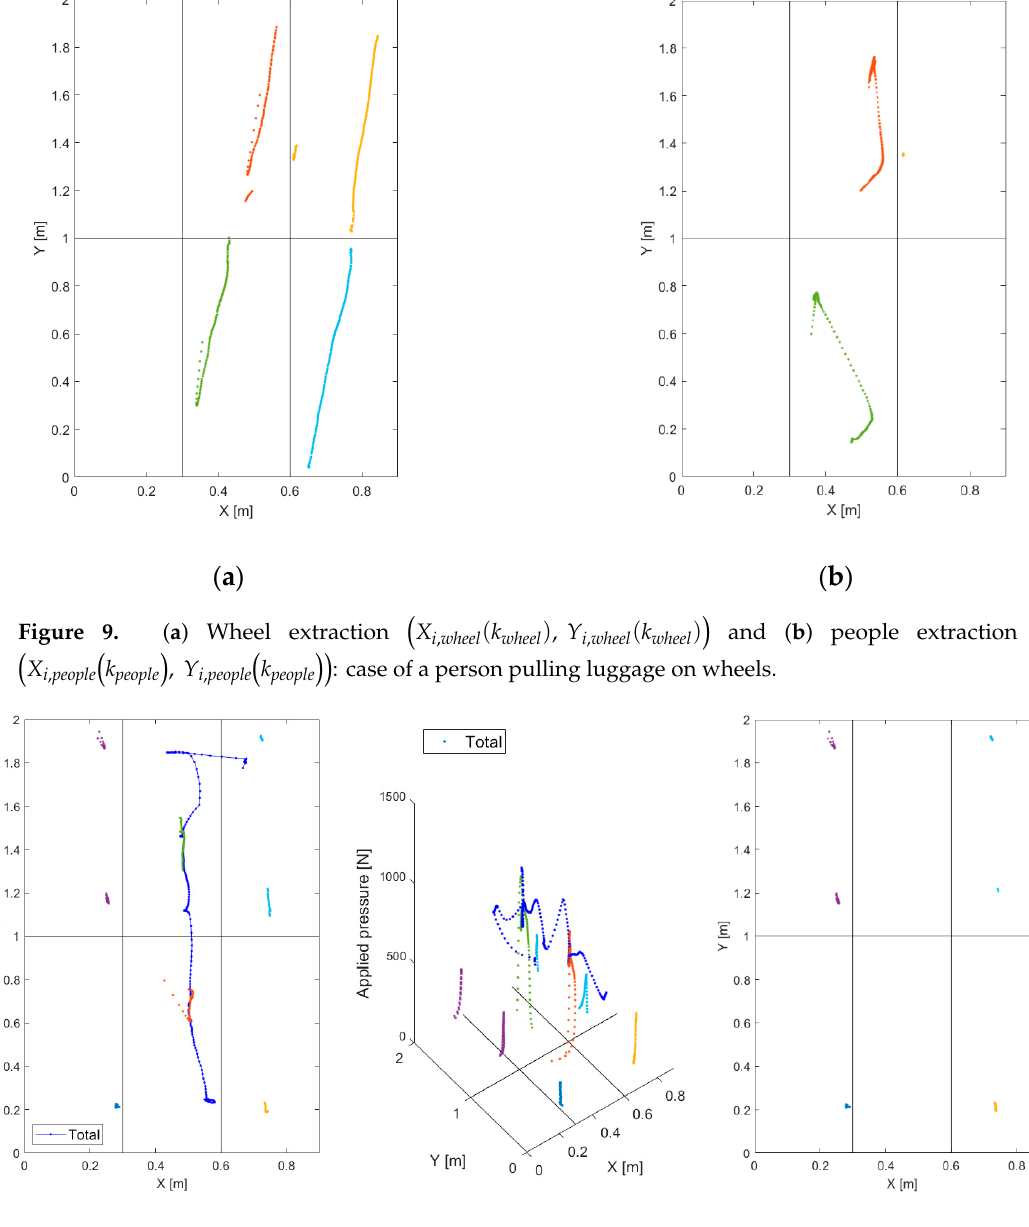
( b ) Figure 11. ( a ) Mean and variance of 𝑌 (cid:3043)(cid:3032)(cid:3042)(cid:3043)(cid:3039)(cid:3032) coordinate after people extraction; ( b ) mean and variance of 𝑌 (cid:3046)(cid:3043)(cid:3042)(cid:3047) coordinate after pressure spot extraction. The confusion matrix of Figure 12 summarizes the results for the second-tier event recognition algorithm. During this performance evaluation, we considered as input only the special events (301 in total), neglecting the errors introduced by the first step event recognition algorithm. Thus, we could assess the performance of the second-tier event recognition algorithm independently. Lastly, the confusion matrix of Figure 13 recaps the overall performance of the entire classification method, in terms of true/false positive (TP and FP) and true/false negative (TN and FN) alarms (see Table 1).